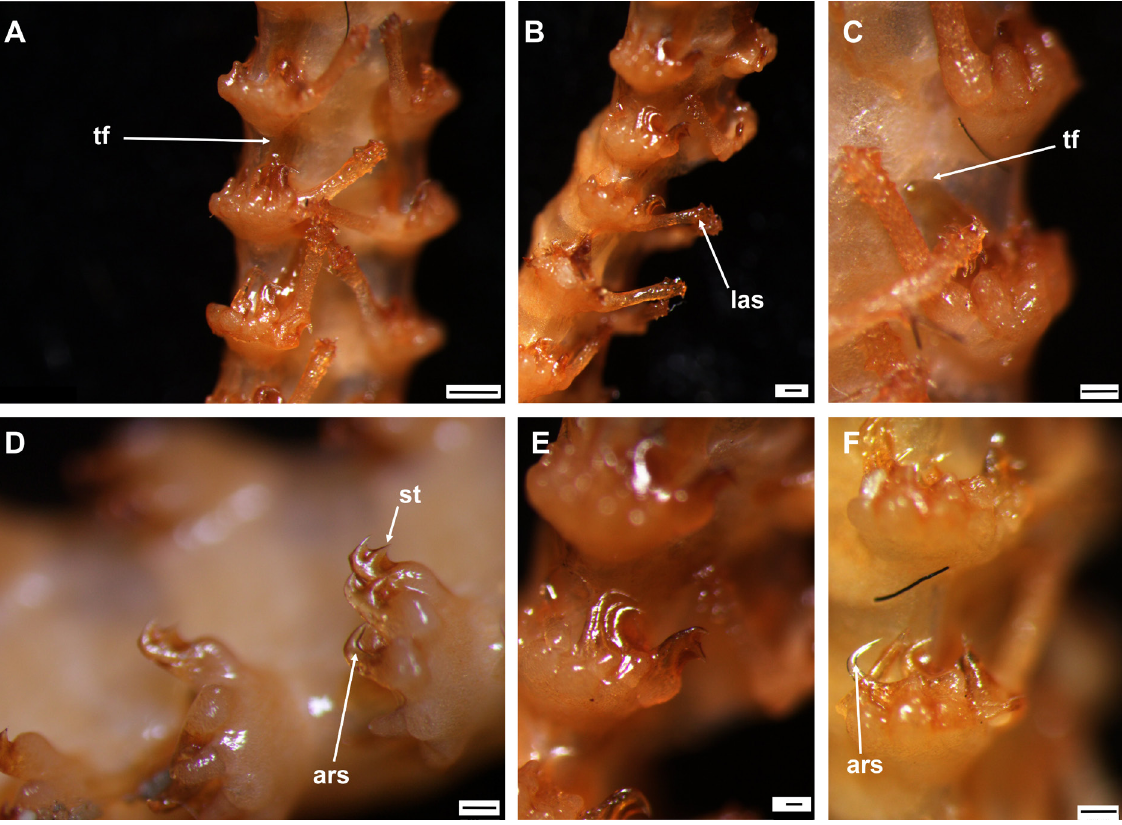
Fig. 5. Asteronyx luzonicus Döderlein, 1927 (IDSSE EEB-SW0003). A–F . Various shapes of arm spines along the arm. Abbreviations: ars = arm spine; las = lowermost arm spine; st = secondary tooth; tf = tube foot. Scale bars: A = 500 µm; B–F = 200